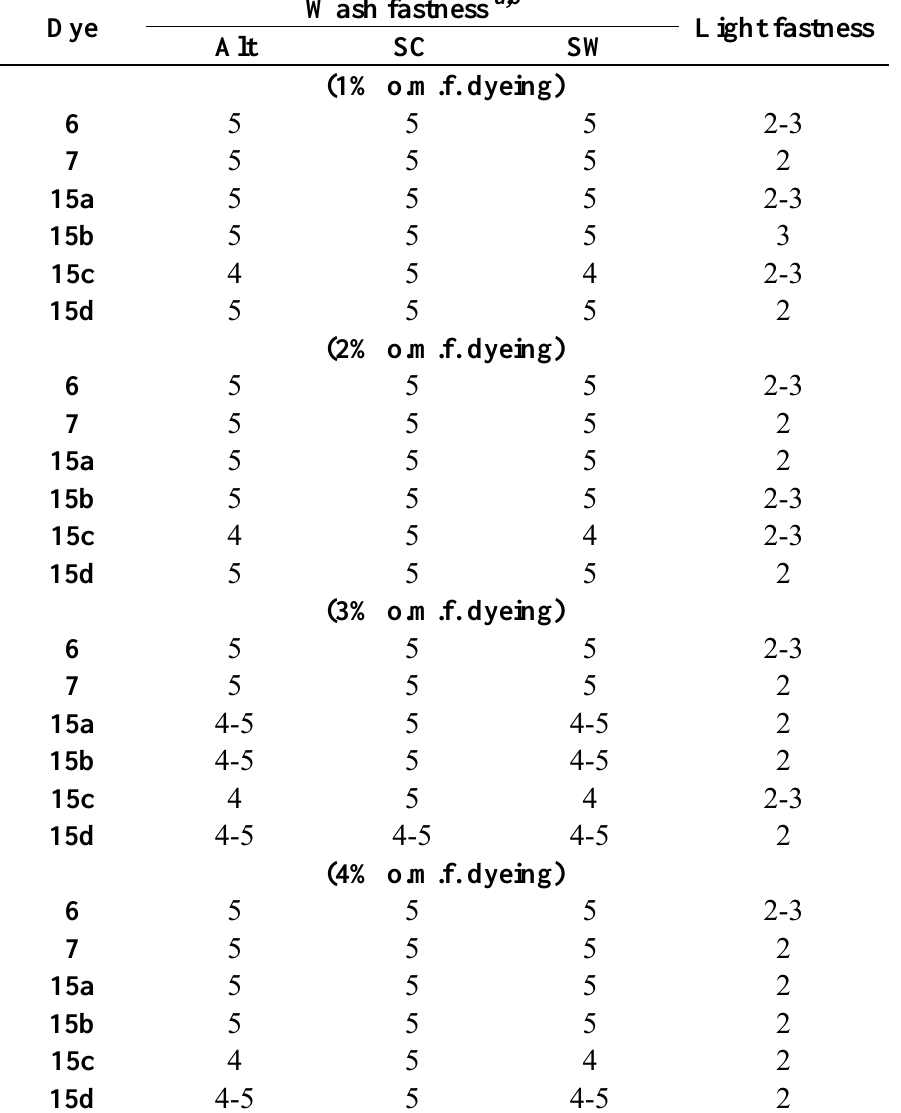
Table 2. Fastness properties of azo disperse dyes on polyester fabrics, prepared by using high temperature dyeing method